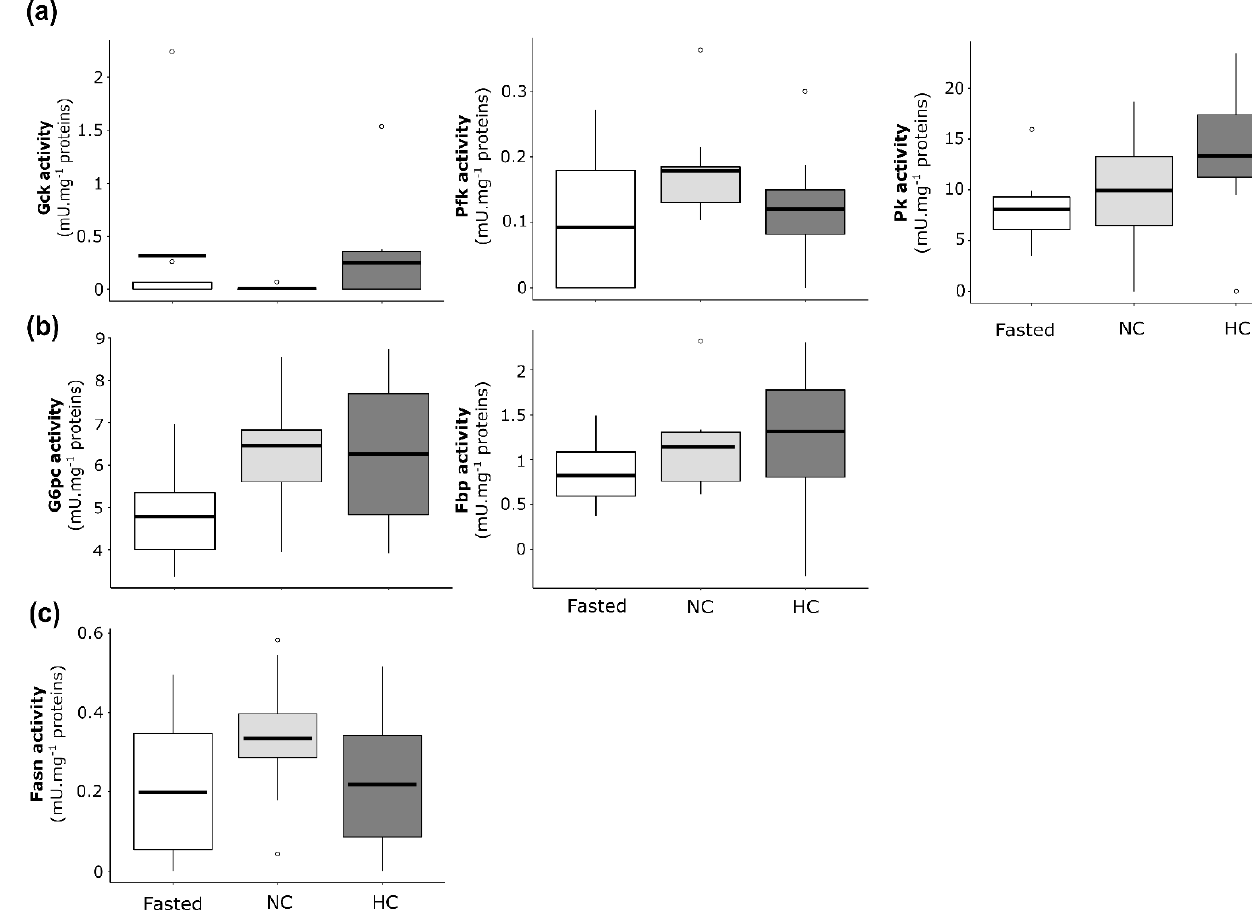
Figure 5. Enzymatic activities of glucose and lipid metabolism in the liver of mature male rainbow trout fasted for 15 days (Fasted, white), fed with a non-carbohydrate diet (NC, grey) and fed with a high-carbohydrate diet (HC, dark grey). Enzymatic activities are expressed as mU.mg −1 of proteins for ( a ) glycolysis with the glucokinase (Gck), the phosphofructokinase (Pfk) and the pyruvate kinase (Pk), ( b ) gluconeogenesis with the glucose-6-phosphatase (G6pc) and the fructose-1,6-bisphosphatase (Fbp) and ( c ) de novo lipogenesis with the fatty acid synthase (Fasn).